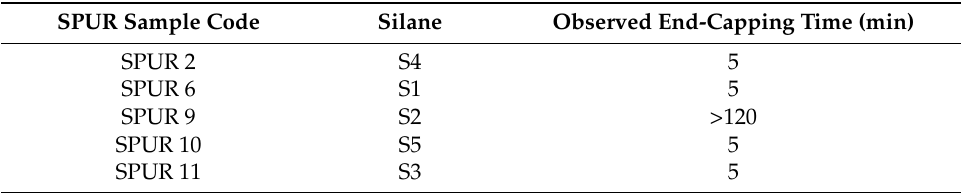
Table 6. The evaluation of reactivity of different silanes. SPUR Sample Code Silane Observed End-Capping Time